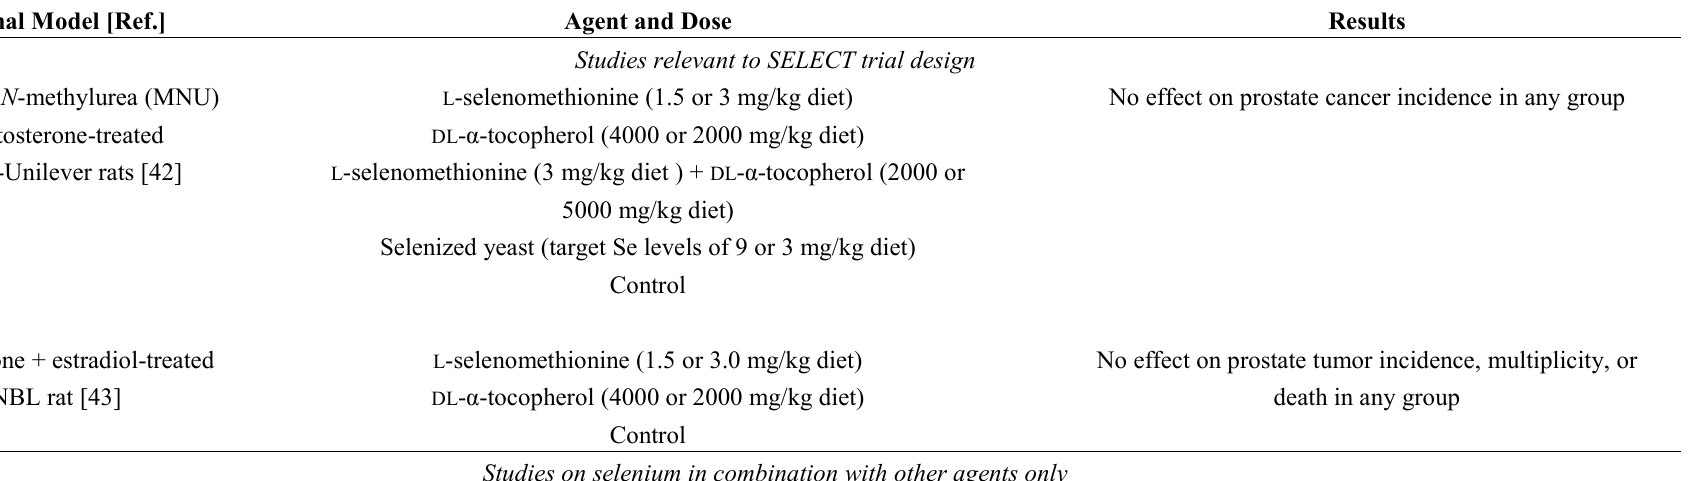
Table 1. In vivo animal studies that assessed prostate cancer prevention by selenium. Animal Model